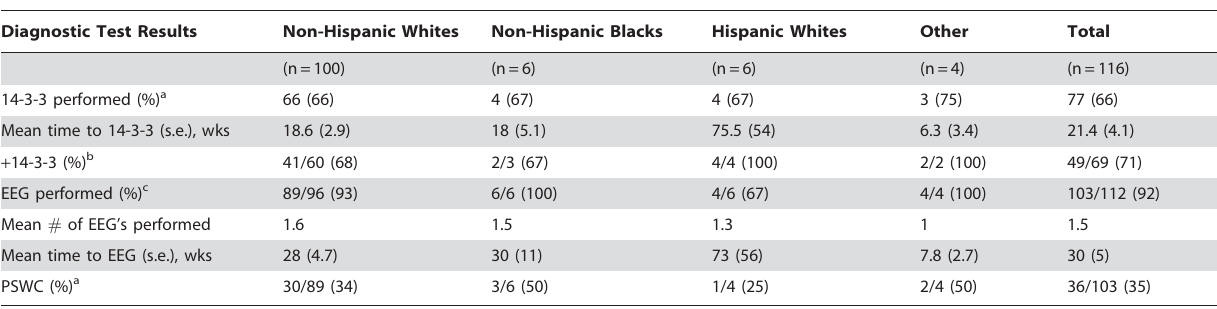
EEG=electroencephalogram; PSWC = periodic sharp wave complexes. a Unknown in 9 cases. b Unknown in 8 cases. c Unknown in 4 cases.